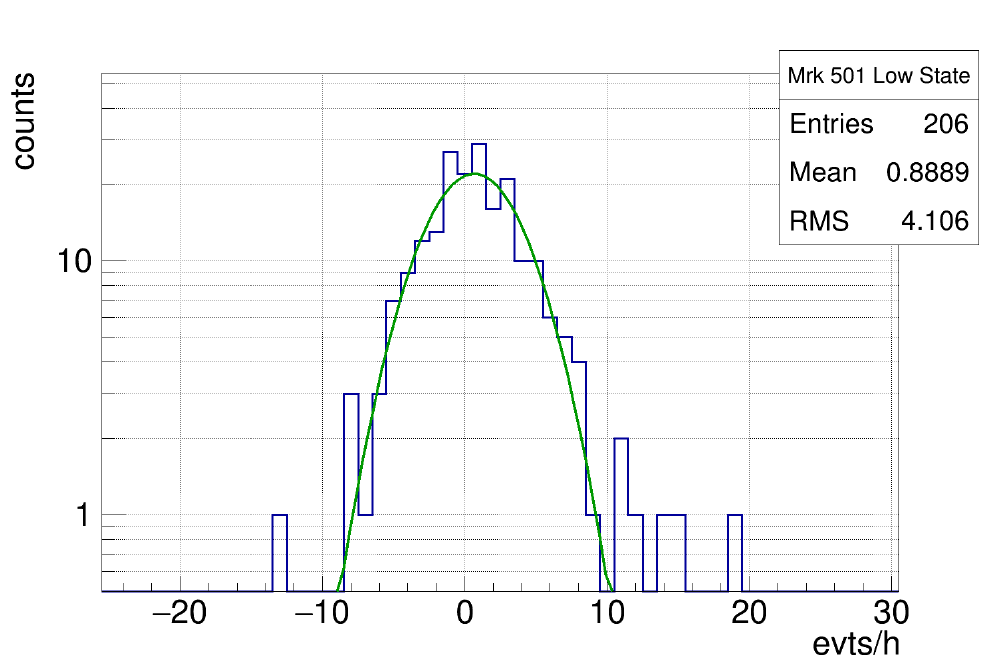
Figure 3. Distribution of nightly fluxes of Mrk501 in 2017 and 2018, as measured by